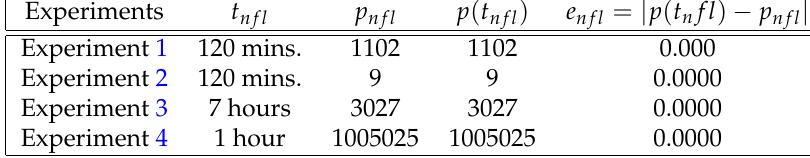
Table 5. The summary of the accuracy of results generated via the scheme (40) against exact solution